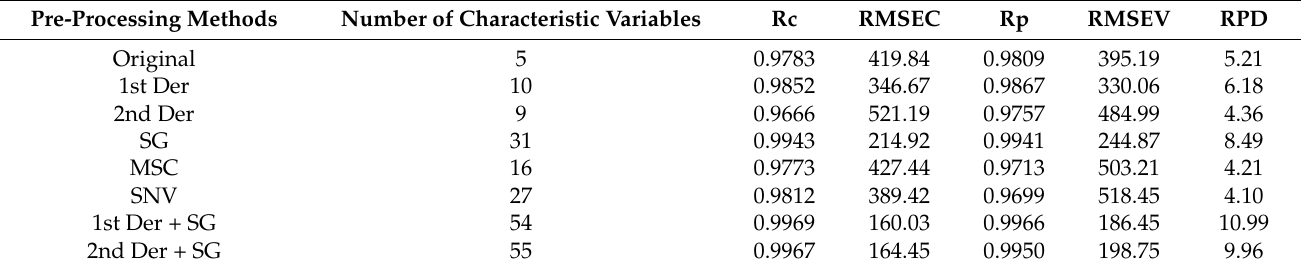
Table 3. Comparing PLSR results after extracting spectral features by successive projection algorithm.